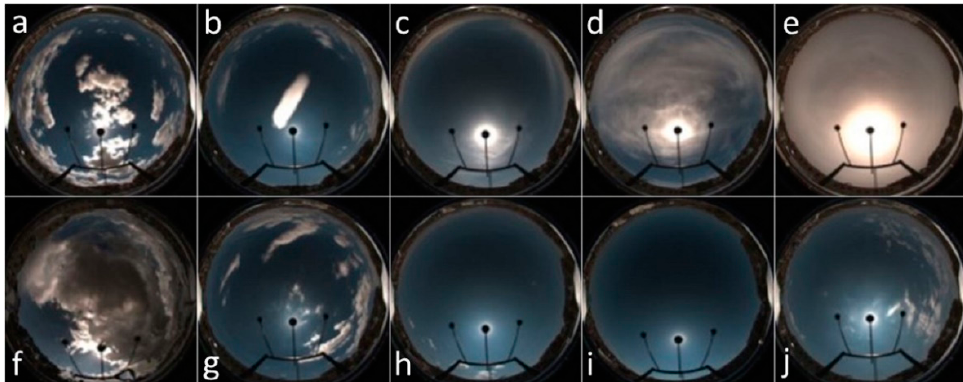
Figure 4. Images of the typical conditions dominating along the measurement periods in the campaign carried out during the spring of 2015. From left to right and from top to bottom: ( a ) April 28, 11:21, scattered/broken clouds; ( b ) April 30, 11:27, clear sky, but with a very thin high cloud near the line of sight; ( c ) May 4, 10:29, high clouds; ( d ) May 7, 11:00, high clouds; ( e ) May 13, 10:45, high clouds with an aerosol intrusion; ( f ) May 15, 15:18, broken clouds; ( g ) May 26, 10:34, clear sky alternating with high or broken clouds; ( h ) June 1, 9:45, clear sky; ( i ) June 2, 8:45, very clean sky; ( j ) June 3, 10:55, clear sky alternating with scattered clouds. All times are UTC.